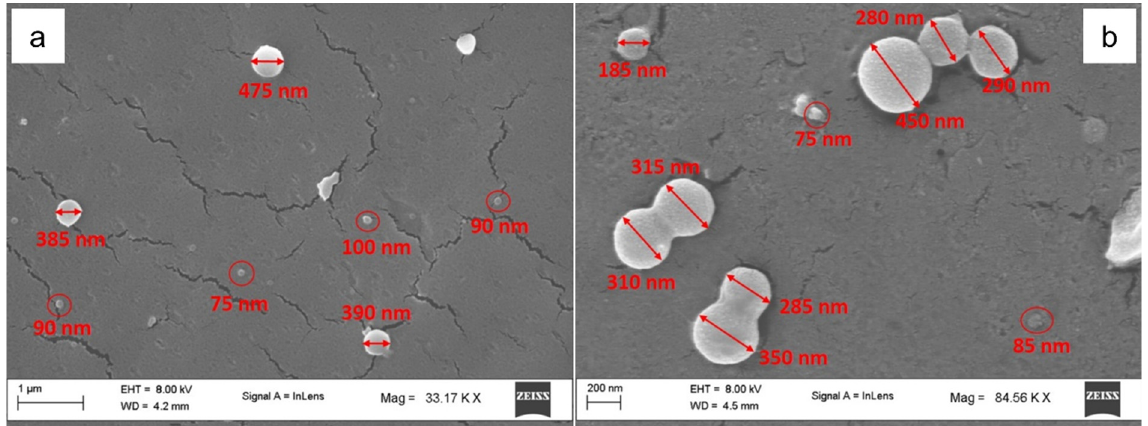
Figure 2. SEM image of ( a ) Or-NCPs and ( b ) Th-NCPs.